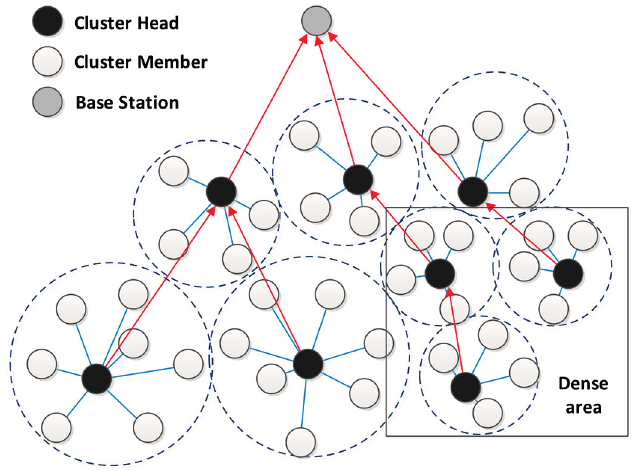
Figure 3. The performance of DCPVP in dense